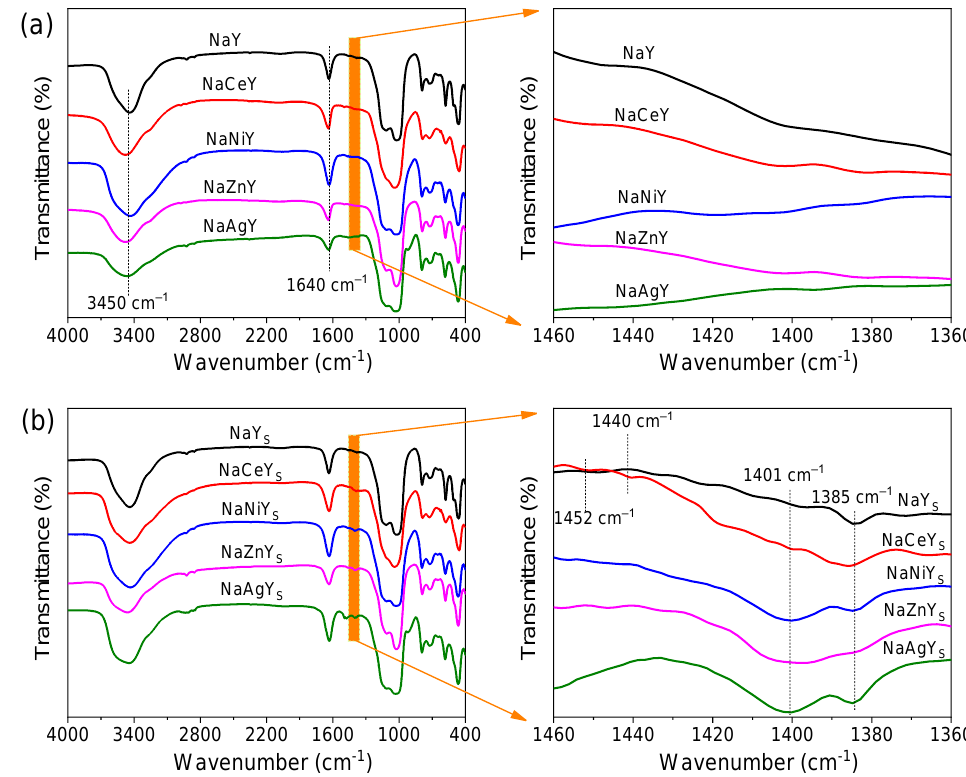
Figure 7. FT-IR spectra of Y zeolites before ( a ) and after ( b ) desulfurized in simulated COG at 100 ◦ C. If the sulfur atom of thiophene directly interacts with metal as a bond, the electron density of carbon atoms in thiophene will increase, leading to a blue shift of C=C stretch- ing [45,46]. Therefore, the peak at 1452 cm − 1 is assigned to the blue shift of 1401 cm − 1 , and it reflects chemisorption of S-M bond. The peak at 1440 cm − 1 is assigned to the stretching vibration of S-Ce bond [47]. For NaCeY S sorbent, the appearance of peaks at 1452 cm − 1 and 1440 cm − 1 proves the existence of S-Ce bond in NaCeY S sorbent (Figure 7b), indicating that Ce ion in Y zeolite could also adsorb thiophene via a direct S-Ce bond. Ni 2+ in NaNiY zeolite can adsorb thiophene via S-Ni bond, which is observed at room temperature [48]. In this work, NaNiY S sorbent has no characteristic peak of 1452 cm − 1 , implying that in coke oven gas S-Ni bond almost disappears at 100 ◦